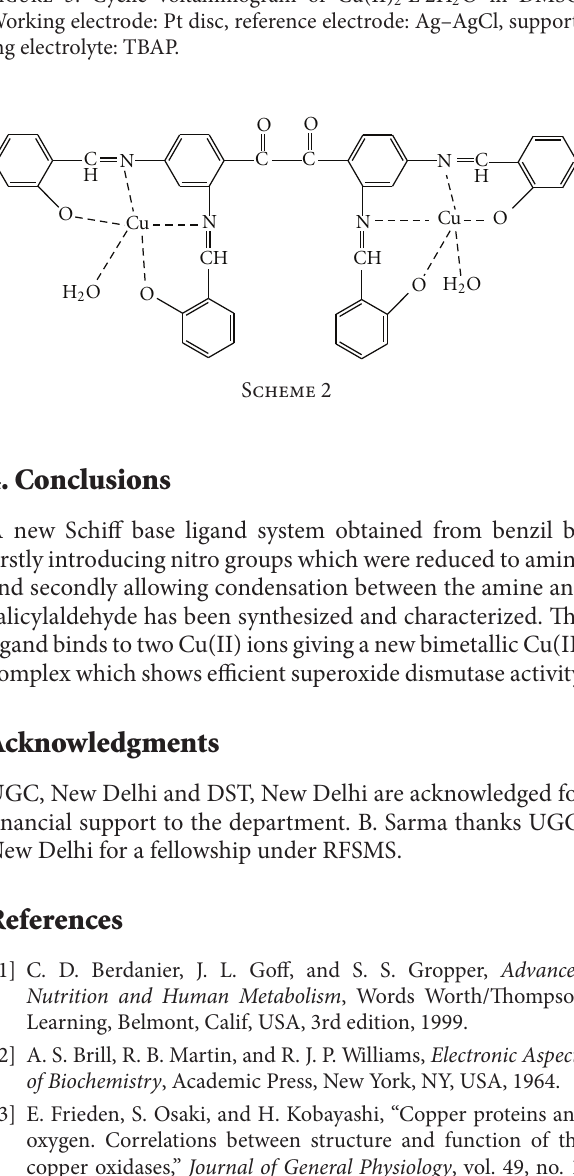
F 5: Cyclic voltammogram of Cu(II)